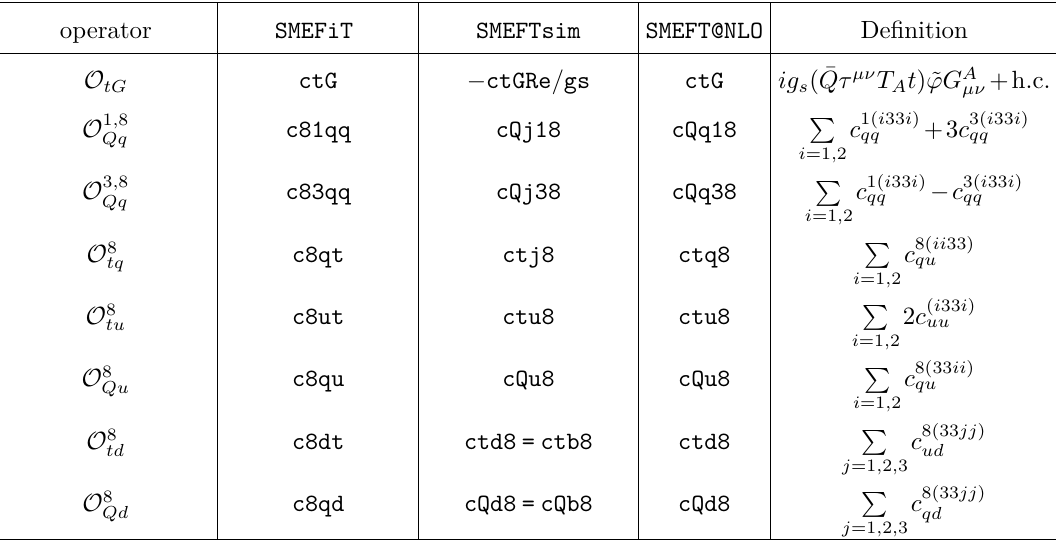
Table 2. The SMEFT operators entering inclusive top-quark pair production. We indicate their definition in terms of the SM fields and the notation used for corresponding Wilson coefficients in SMEFTsim (in the topU3l flavor scheme), SMEFiT , and SMEFT@NLO . The = sign indicates that two coefficients are fixed to the same value